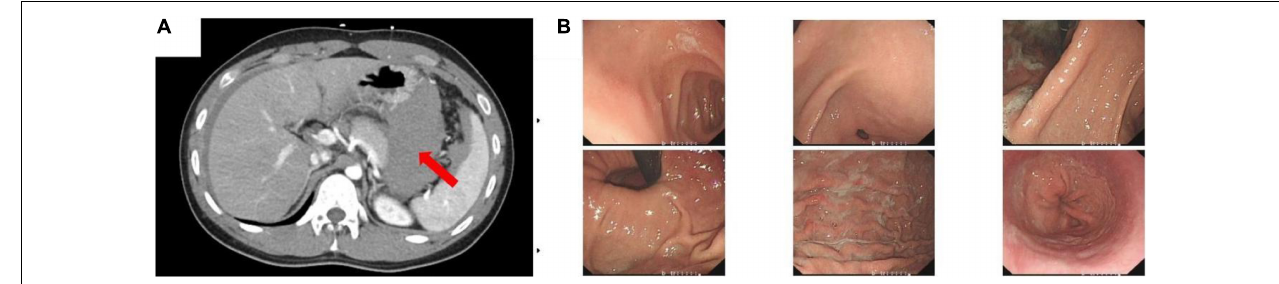
FIGURE 1 | (A) Enhanced computed tomography (CT) of the abdomen. Red arrow showed a 10 × 5.2 cm 2 high-density shadow in the gastro-pancreatic gap. (B) Gastroscopy showed that the gastric mucosa was smooth and had no ulcer or bleeding spot in the upper digestive tract.